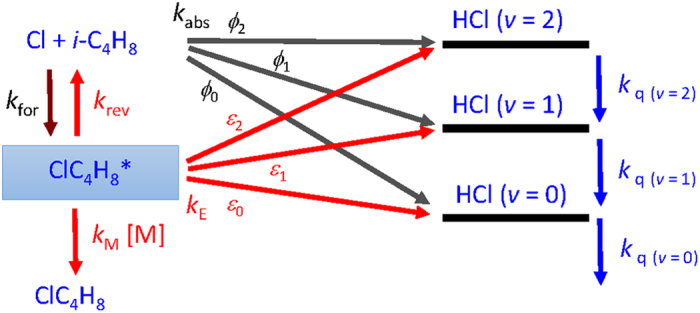
Reaction mechanism of Cl + i-C4H8.